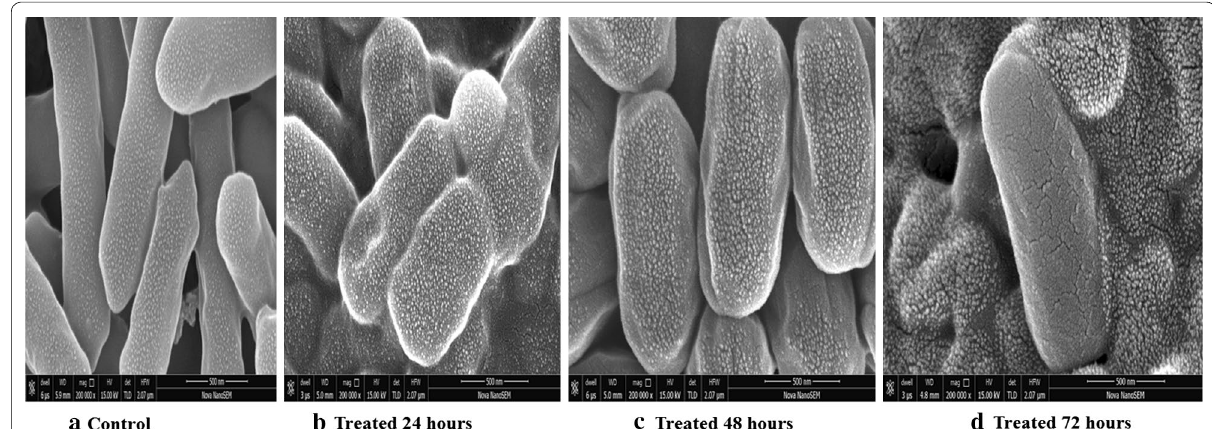
Fig. 4 Field emission scanning electron microscope photographs of Bacillus subtilis MTCC2413 subjecting to 25 mg/ml at various time interval of 24, 48 and 72 h. The images were taken at 500 nm resolution. a Control, b treated 24 h, c treated 48 h, d treated 72 h